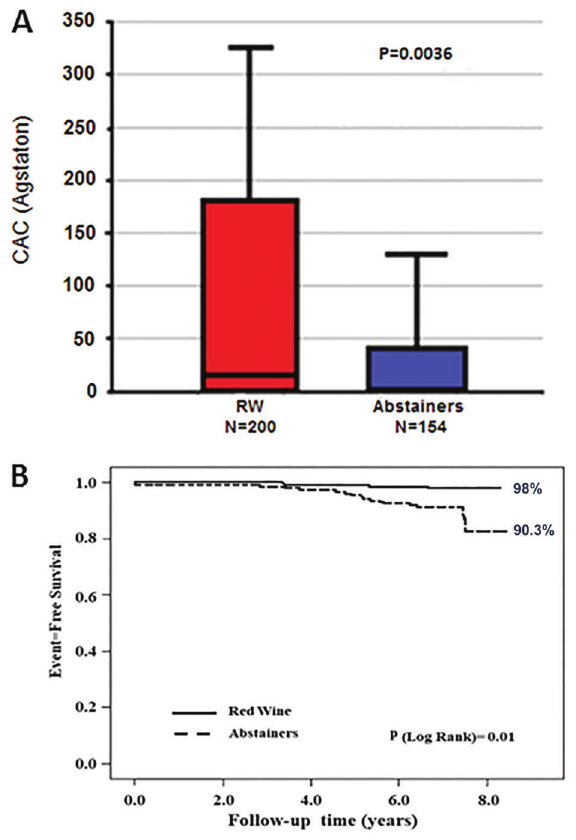
Figure 1 . A , Boxplot graphic of coronary artery calcium (CAC) scores in red wine (RW) consumers and abstainers. B , Event-free (death, acute myocardial infarction, revascularization) survival rates in red wine consumers vs